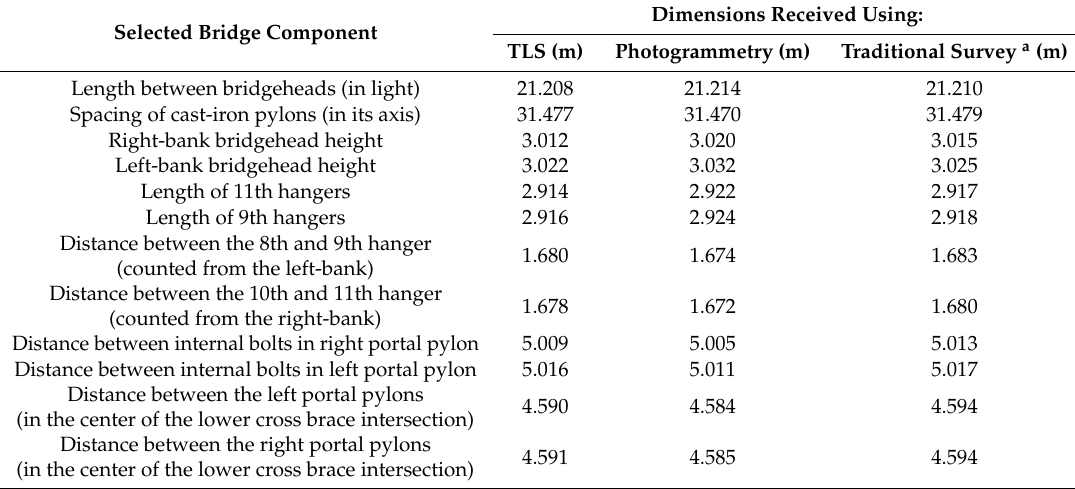
Table 1. Examples of received dimensions of bridge components using the TLS, photogrammetric and traditional